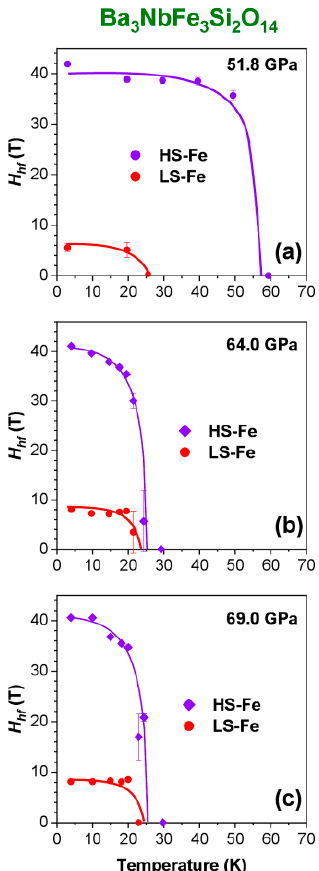
Figure 12. (Colour on-line) Temperature dependences of the magnetic hyperfine field H hf at iron nuclei in Ba 3 NbFe 3 Si 2 O 14 estimated from Mössbauer spectra at high pressures above the spin crossover HS → LS transition. ( a ) 51.8 GPa; ( b ) 64 GPa and ( c ) 69 GPa. Solid lines are the guides for the eye.